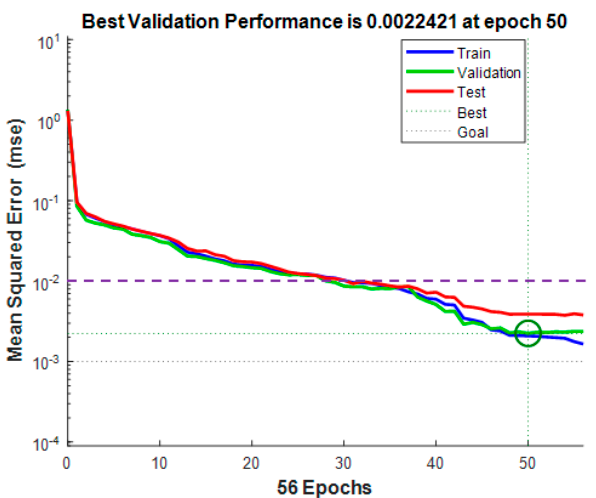
Figure 5. The performance of the BP neural network after